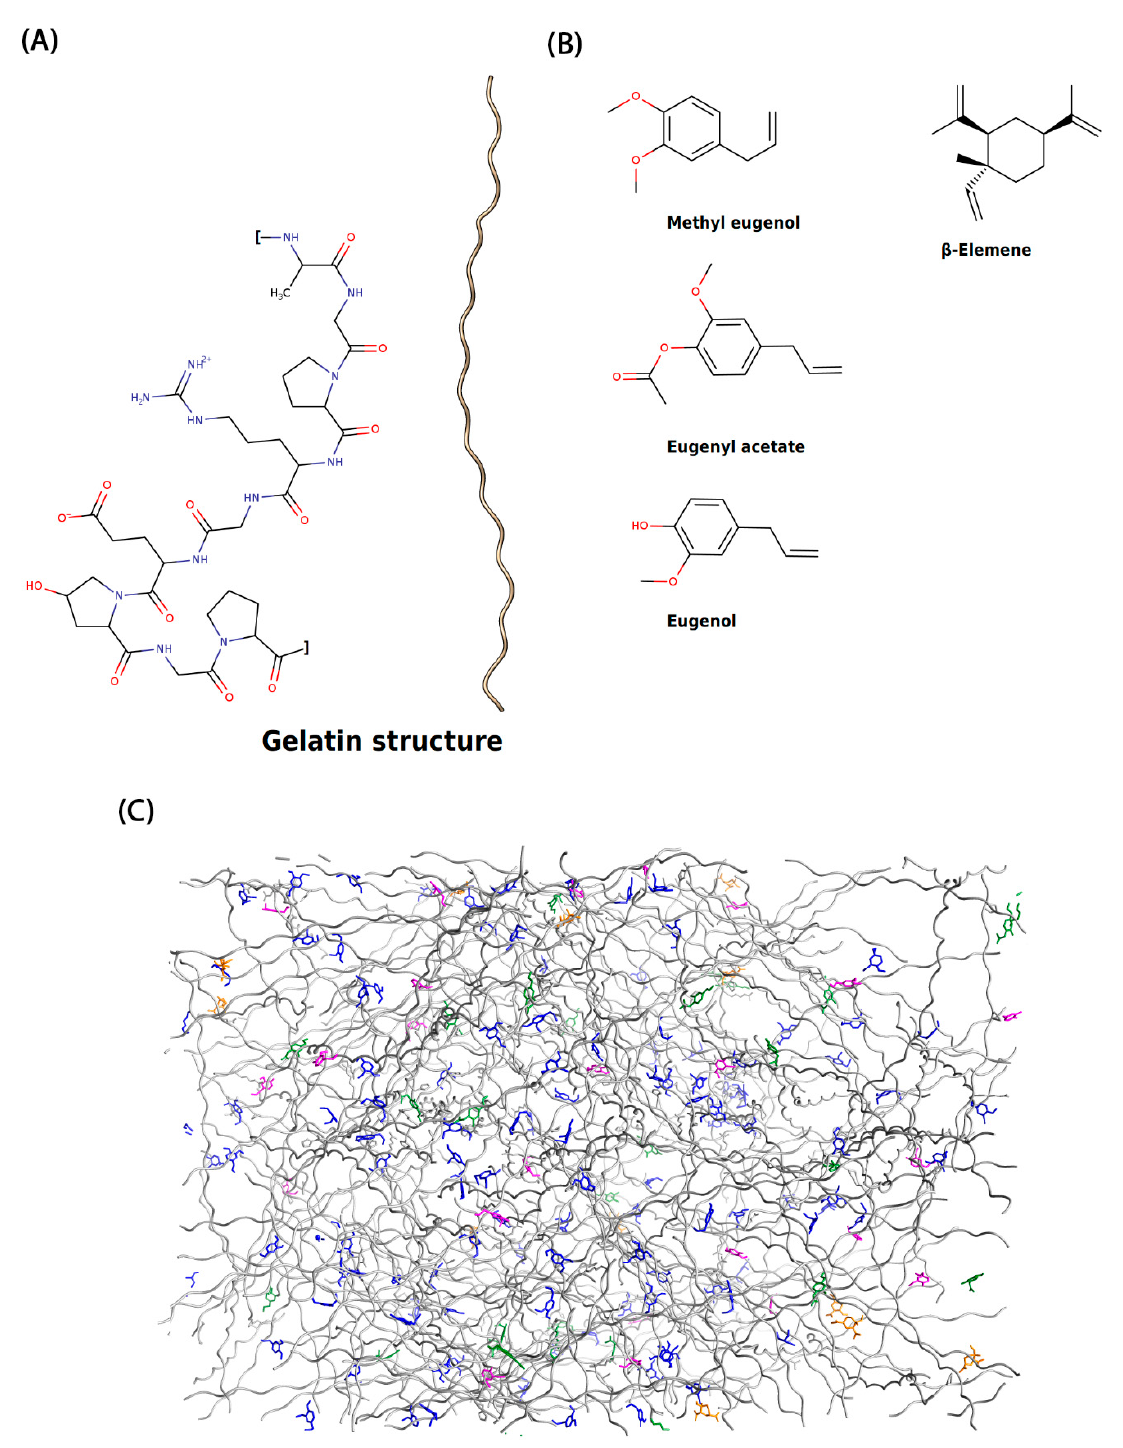
Figure 1. ( A ) Molecular structure of gelatin where the typical amino acids of the structure and its three-dimensional structure with the elemental composition of 50.5% carbon, 25.2% oxygen, 17% nitrogen, and 6.8% hydrogen are displayed. ( B ) Major EO compounds have been impregnated into gelatin. The methyl eugenol, eugenyl acetate, eugenol, and β -elemene represent 48.01, 22.55, 10.52, and 7.38% of the total composition of the EO obtained using extraction with supercritical CO 2 fluid at a temperature of 100 °C and a pressure of 100 bar. ( C ) Structural complex showing the arrangement of EO components in the gelatin matrix.